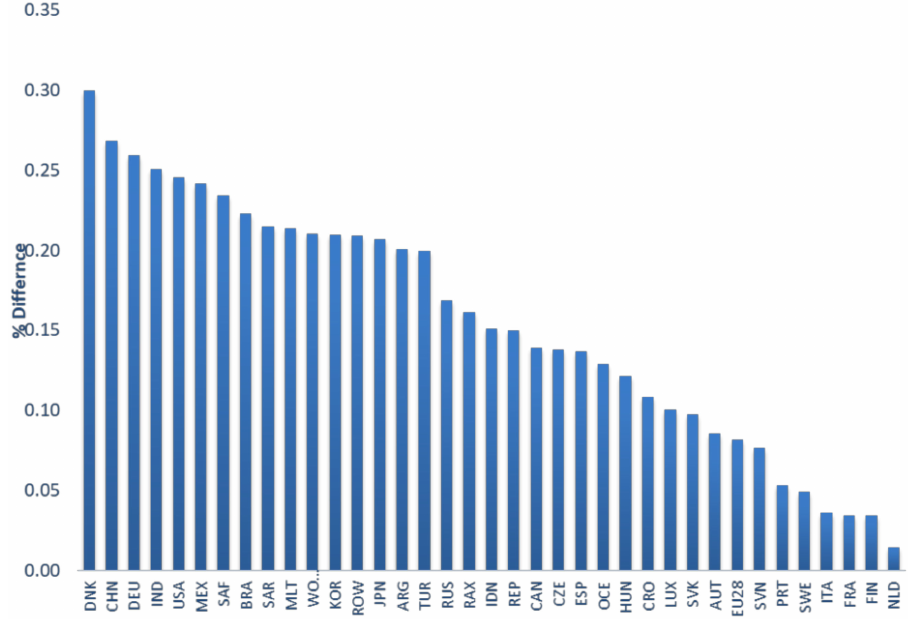
Figure 6. GDP Changes in 2DEG_GRDW in 2050 (% di ff erence from